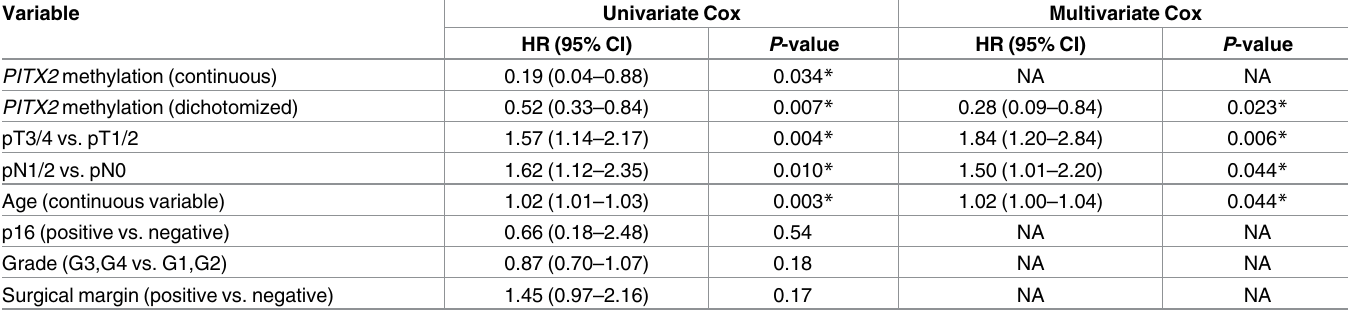
Table 2. Univariate and multivariate Cox proportional hazards analyses. Univariateand multivariate Cox proportional hazards analyseson overallsur- vival in 528 HNSCCpatients.Multivariate Cox proportional hazardanalysiswas conductedincludingonlyvariablesthat showedsignificancein univariate